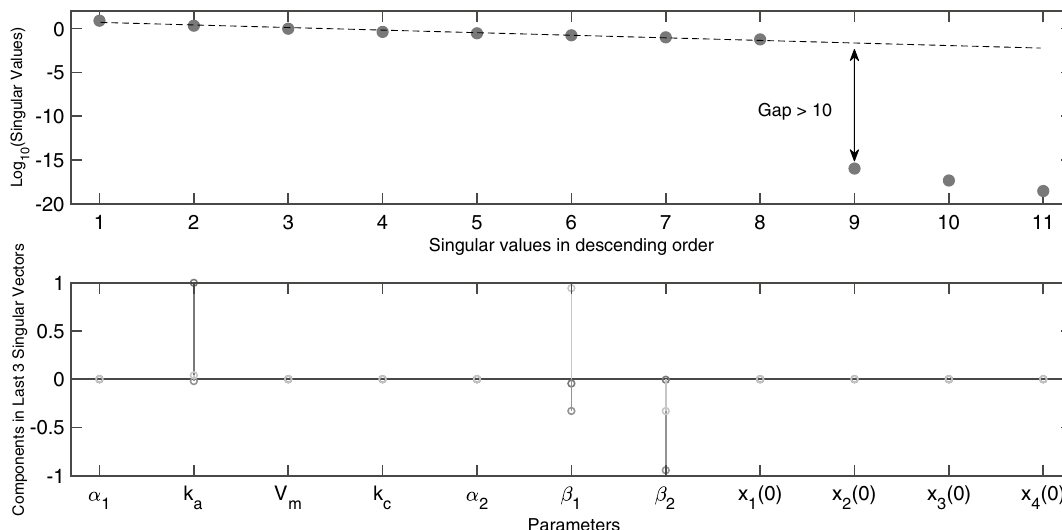
Figure 6. Identifiability signature of the pharmacokinetics model ( M 5 ) for the experimental setup with x 3 ( 0 ) = x 4 ( 0 ) = 0 . (Top) The three singular values beyond the gap suggest that the sensitivity matrix is rank deficient and so the model is not identifiable. (Bottom) Entries in the last 3 columns of the V matrix, related to the 3 zero valued singular values. The nonzero entries suggest that parameters { k a , β 1 , β 2 } are